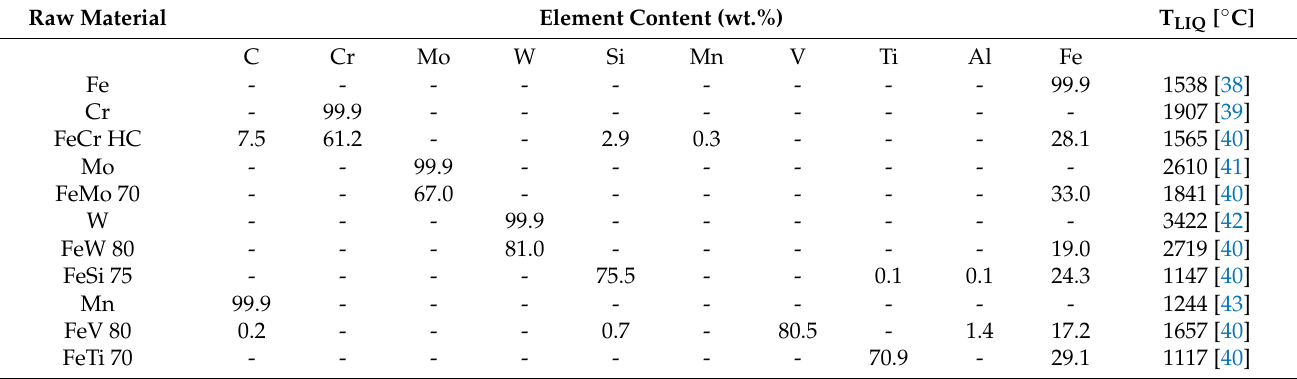
Table 4. Chemical compositions and corresponding T LIQ of typical powder filling particles. Raw Material Element Content